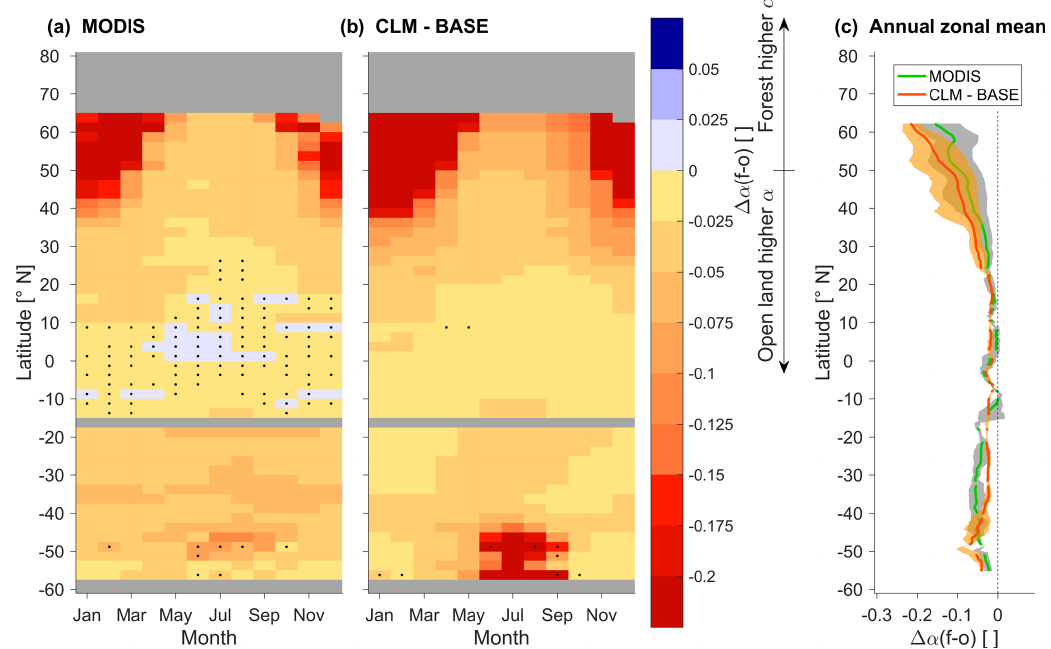
Figure 2. Seasonal and latitudinal variations of (cid:49)α(f − o) in (a) the MODIS observations and (b) CLM-BASE. Points with a mean which is insignificantly different from zero in a two-sided t test at 95% confidence level are marked with a black dot. Only grid cells containing valid data in the MODIS observations were considered for the analysis of CLM-BASE. All data from the 2002–2010 analysis period corresponding to a given latitude and a given month are pooled to derive the sample set for the test. Panel (c) shows the zonal annual mean of both MODIS (in green along with the range between the 10th and 90th percentiles in grey) and CLM-BASE (in red, the range between the 10th and 90th percentiles in orange). Note that on this subfigure results have been smoothed with a 4 ◦ latitudinally running